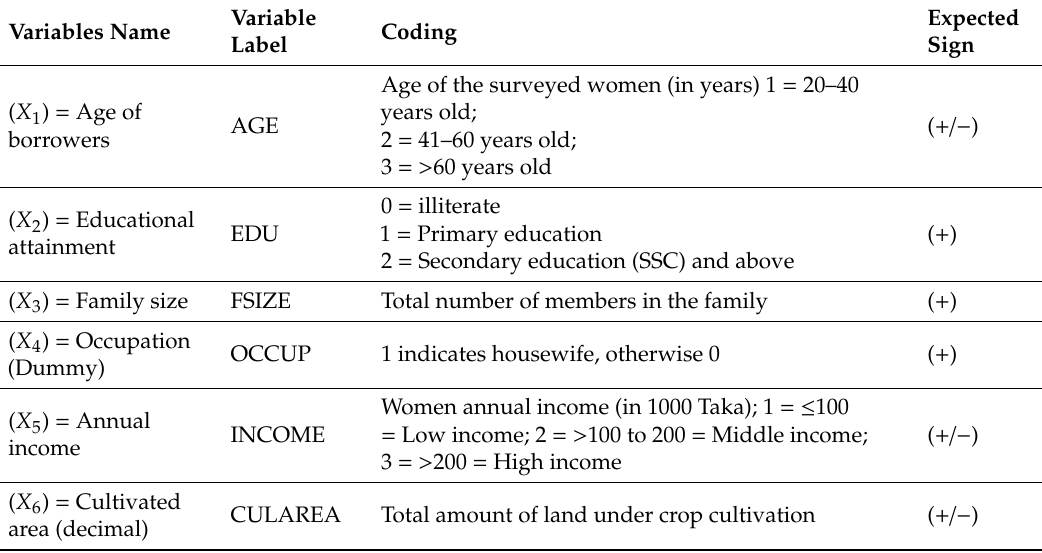
Table 1. Explanatory variables for binary logistic model to assess microcredit